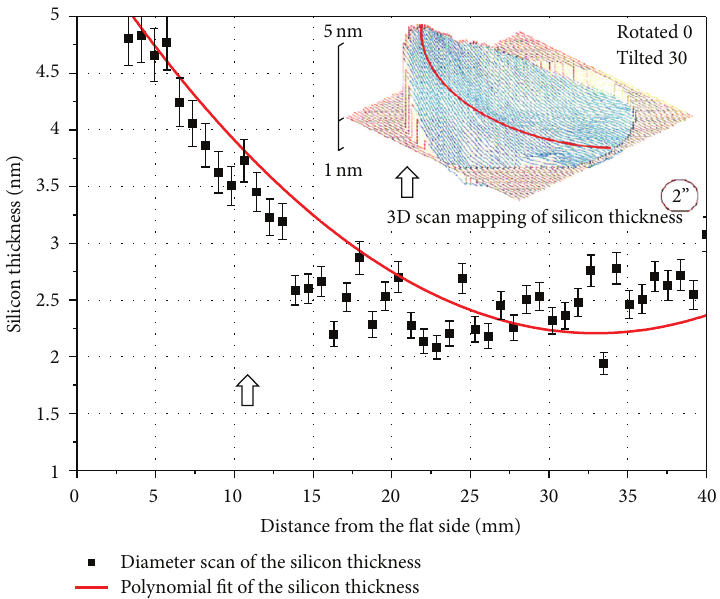
Figure 1: Gradient of SOI thicknesses measured by spectrophotometry across a 2 󸀠󸀠 diameter SIMOX test wafer after thinning using the gate-recessed process. The fitting curve here is serving as a visual guide of the thickness distribution.